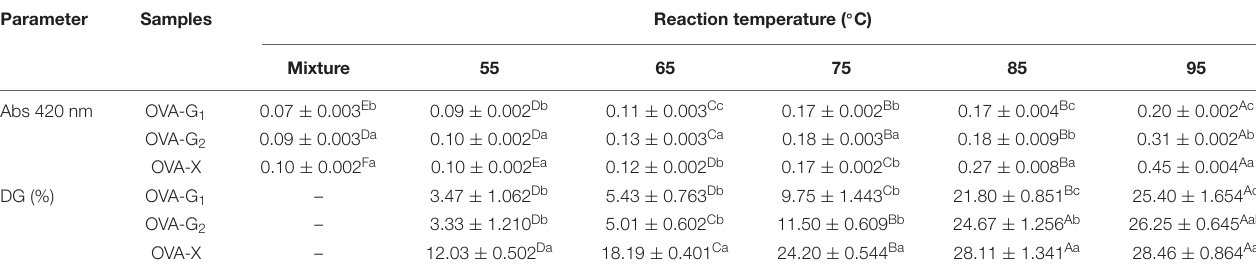
TABLE 1 | The changes in the absorbance (420 nm) and the degree of glycosylation (DG) of OVA, OVA-G 1 , OVA-G 2 , and OVA-X at different reaction temperatures. Parameter